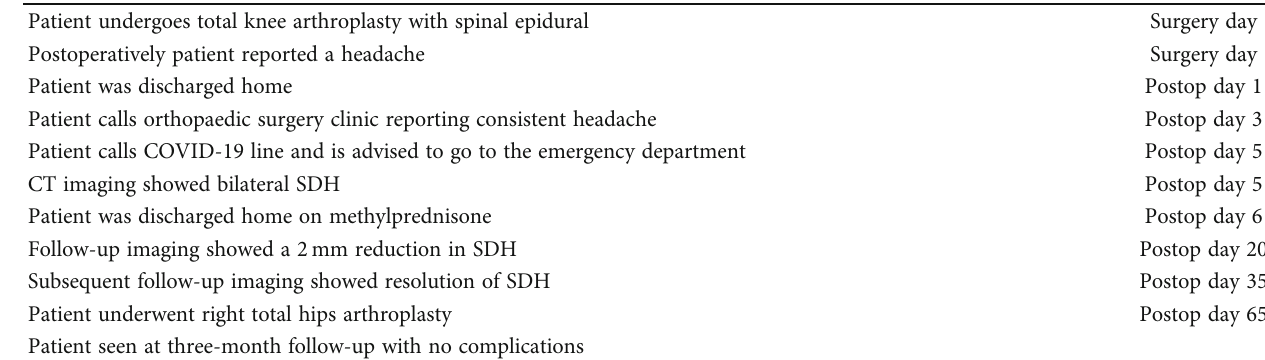
Table 1: Patient